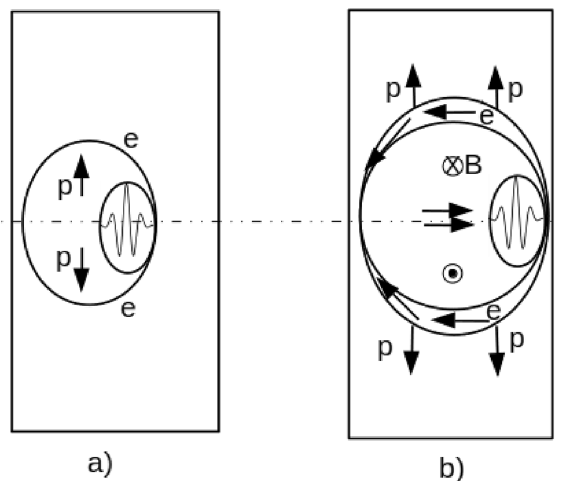
Figure 3. Sketch of the scenario of the pulse laser–matter interaction. ( a ) The action of the laser pushes the electrons radially (denoted e ) which creates a positively charged channel. The protons ( p ) are then accelerated by the induced electric field. ( b ) The high density electron current generates a strong toroidal-shape magnetic field (B). The electron charge accumulation on the channel border allow to re-accelerates the